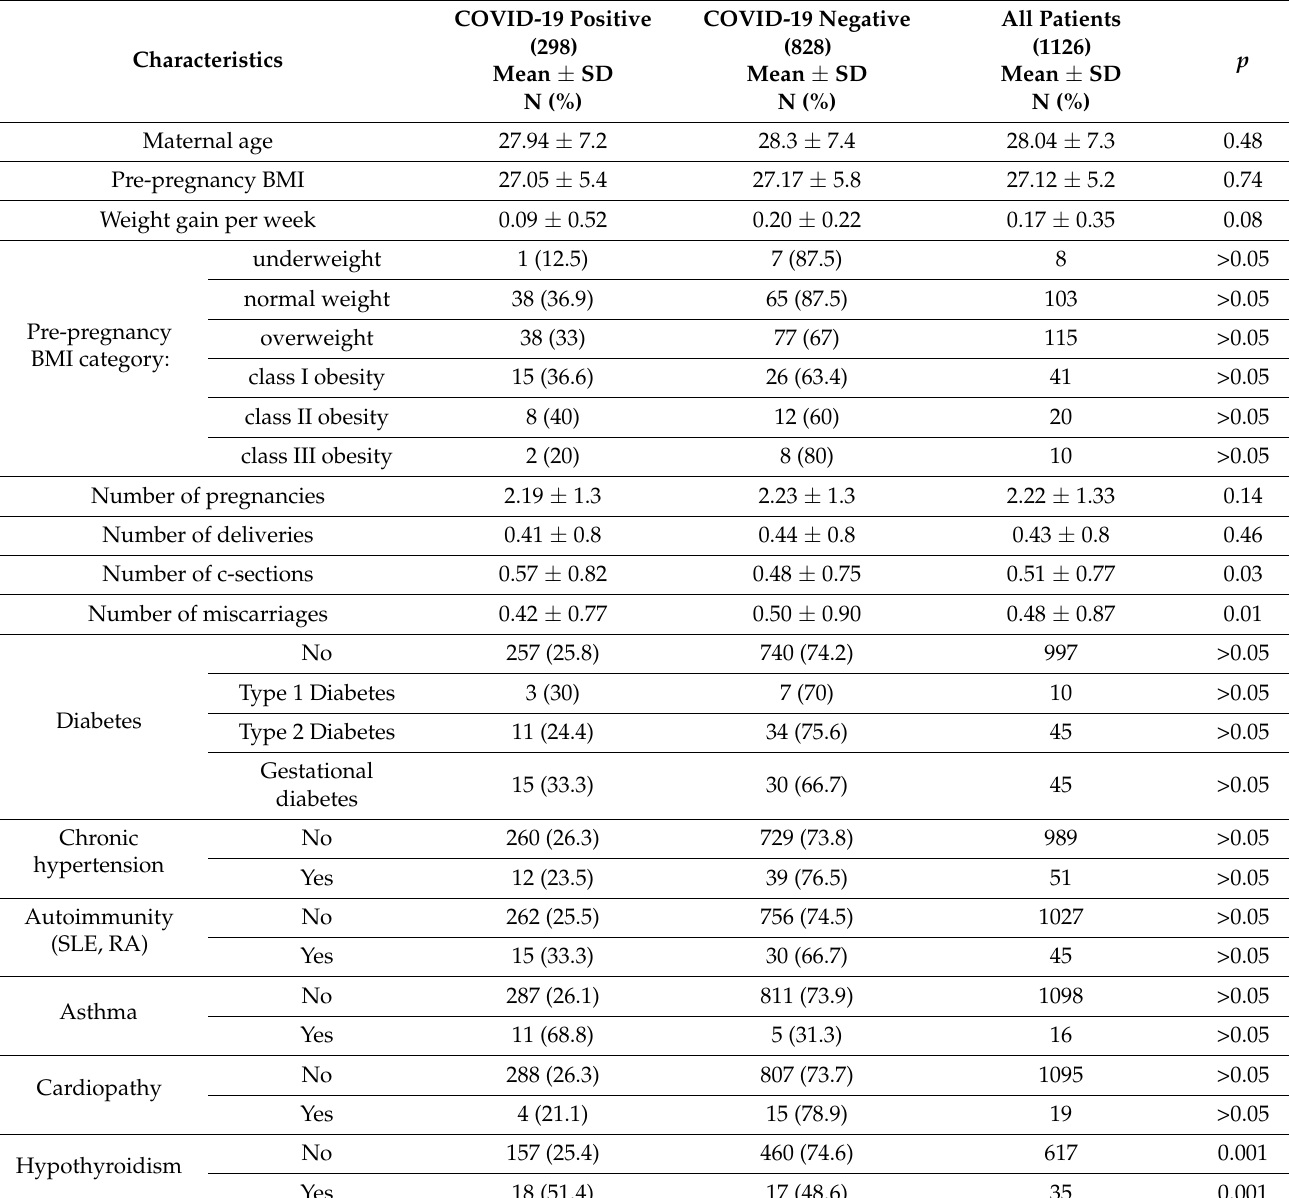
Table 1. Maternal